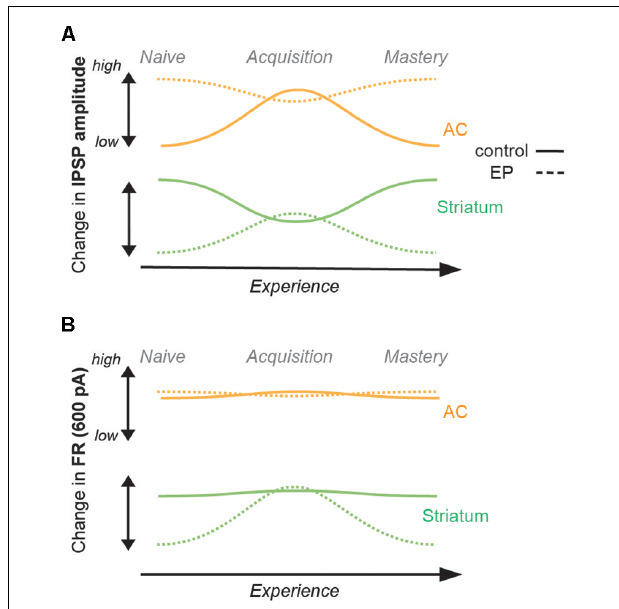
FIGURE 4 | Summary of changes in inhibition and firing rates with learning. (A) Changes in IPSP amplitudes with learning for the control population (straight line), and for the EP population (dashed line). AC (IT and PT) data are shown in orange, and striatal (D1 and D2) data are shown in green. While a significant increase was found in IPSP amplitude of AC cells (both IT and PT cells) in the control population, no significant change was found for the EP group. A significant decrease was found in the IPSP amplitude of striatal cells (both D1 and D2 cells) in the control population, but in contrast, a significant increase was found for the EP group. (B) Changes in FR (Hz, 600 pA) with learning. No change in FR of AC cells was found in the control population, or in the EP group. No change in FR of striatal cells was found for the control population, but in contrast, a significant increase was found for the EP group.